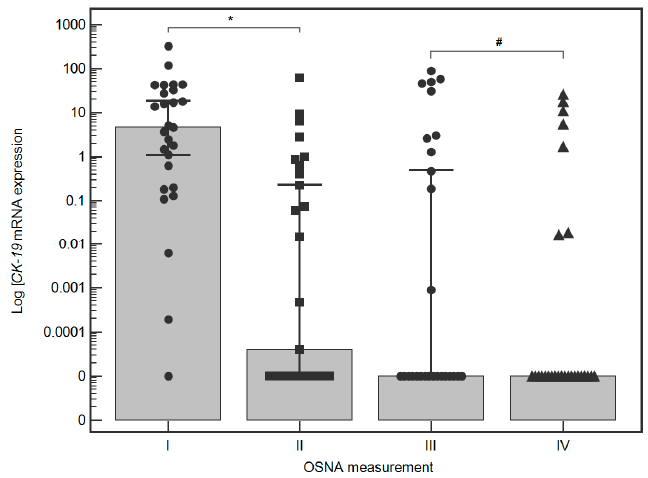
Figure 2. Comparison of four consecutive OSNA measurements performed according to the study protocol. * — p < 0.0012; # — p = 0.0574. protocol. * — p < 0.0012; # — p =